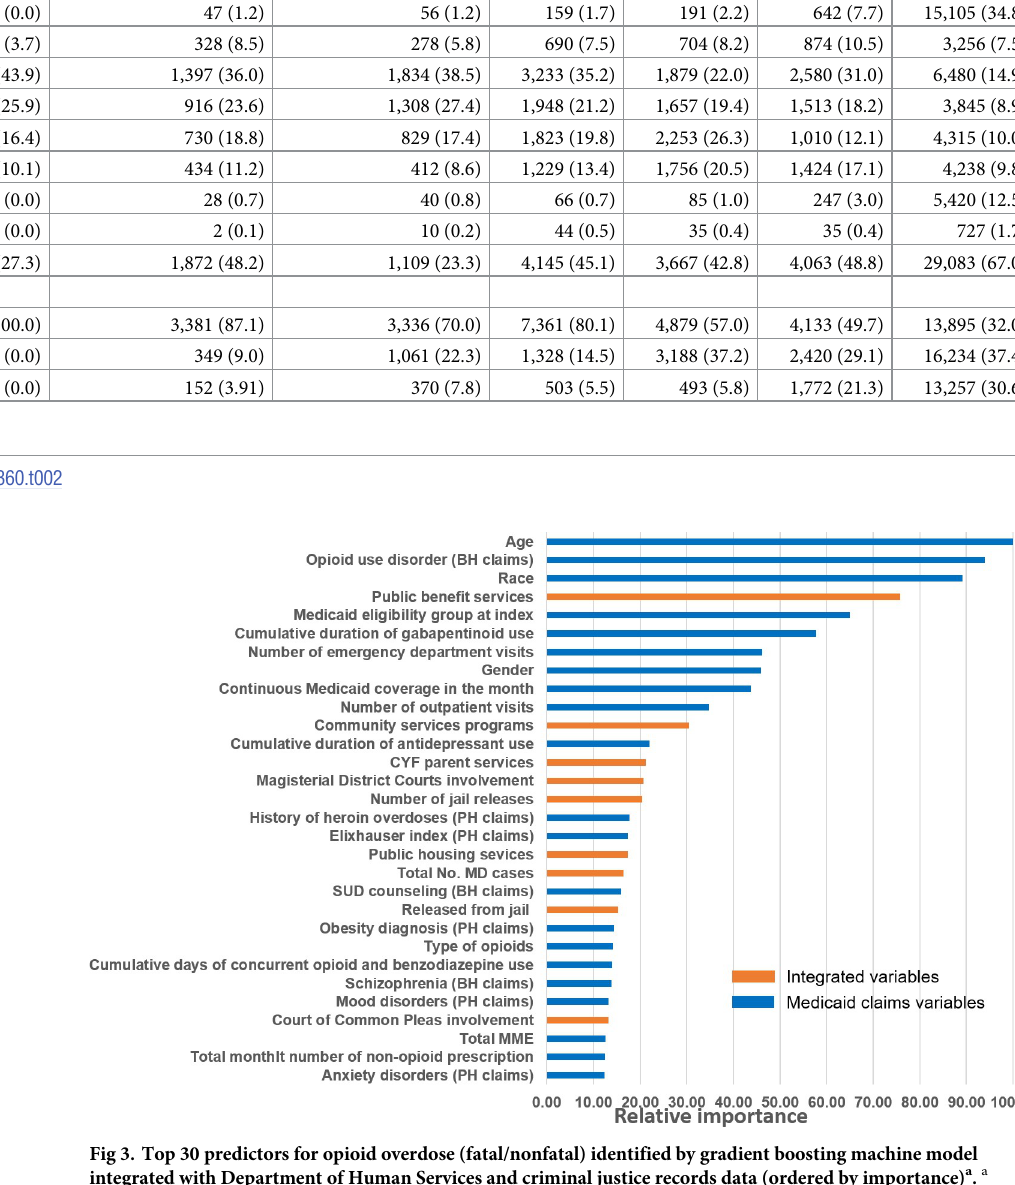
PLOS ONE | https://doi.org/10.1371/journal.pone.0248360 March 18,